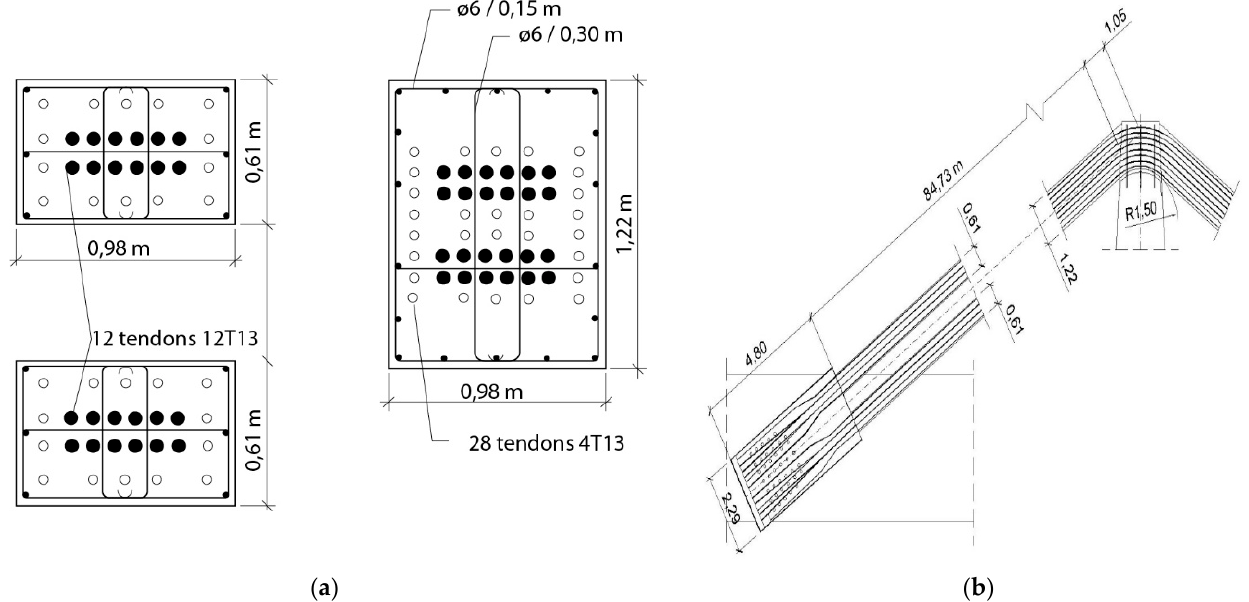
Figure 4. ( a ) Cross-sections of the concreted cable (Morandi, 1968). ( b ) Schematic anchoring of the cable in the deck and at the top of the pylon (Morandi, 1968).